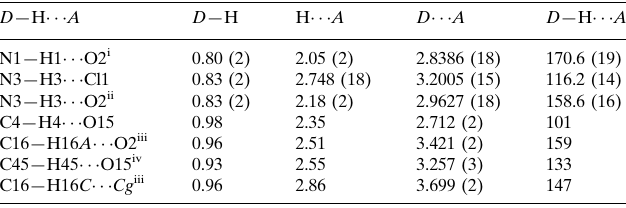
Hydrogen-bond geometry (A˚ , (cid:1)